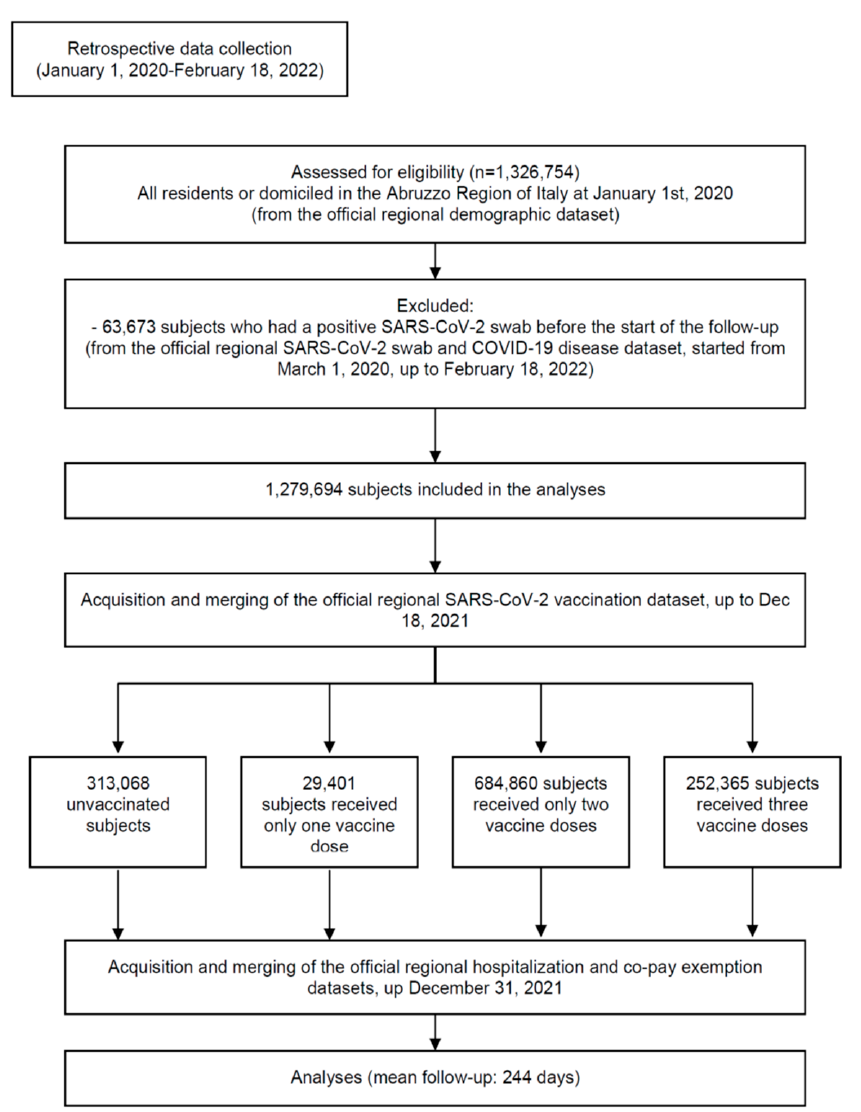
Figure 1. Study flowchart in line with the STROBE (Strengthening the Reporting of Observational Studies in Epidemiology) statement (http://www.strobestatement.org accessed on 16 April